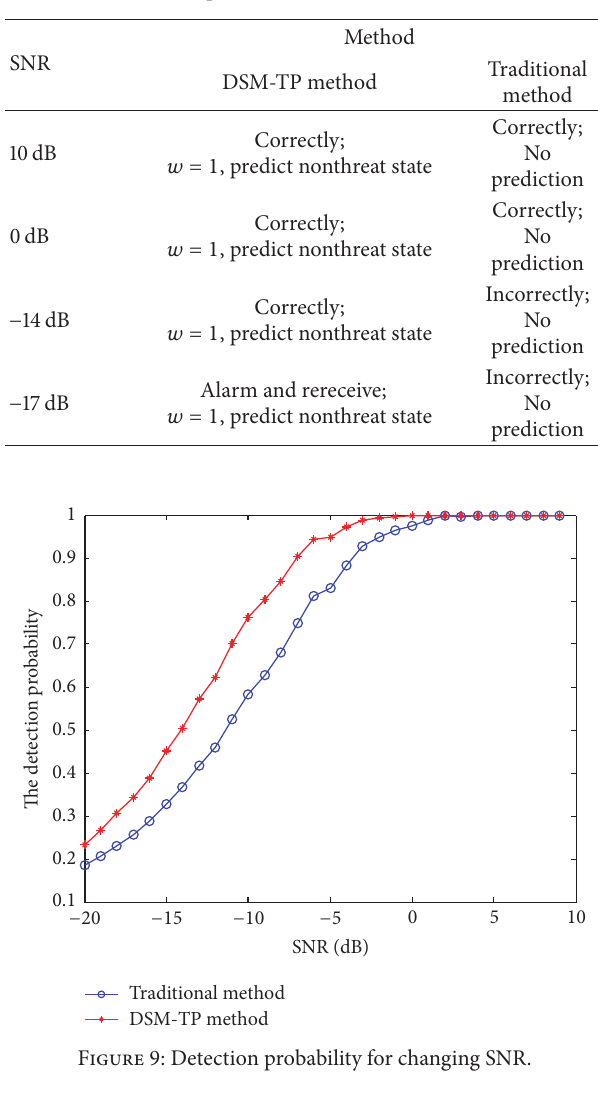
Table 1: Threat prediction results of the two methods.